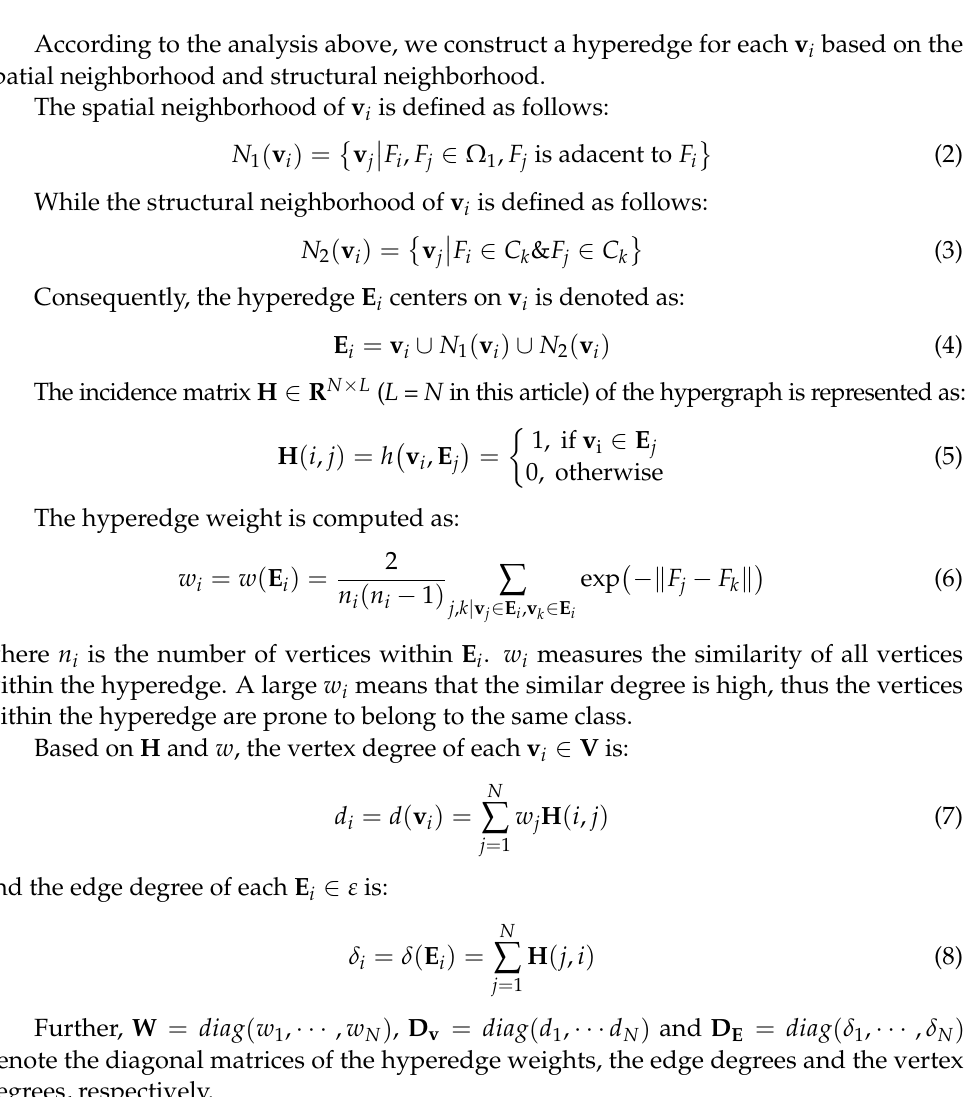
Figure 4. Illustration of dual neighborhood. ( a ) Segmentation under a coarse scale. ( b ) Segmentation under a fine scale.